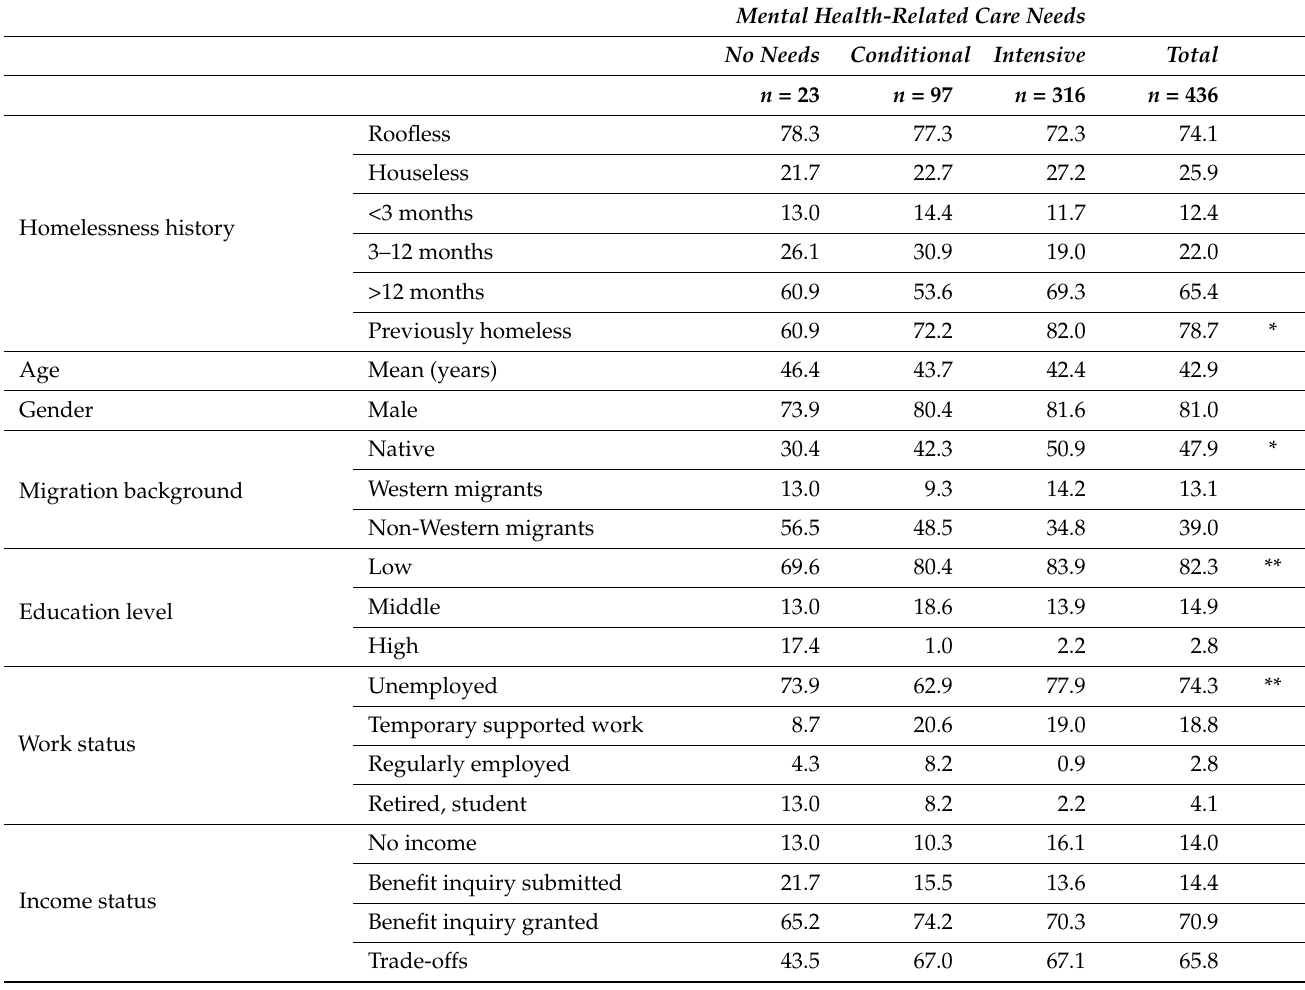
Table 1. Background characteristics of subgroups and total sample.